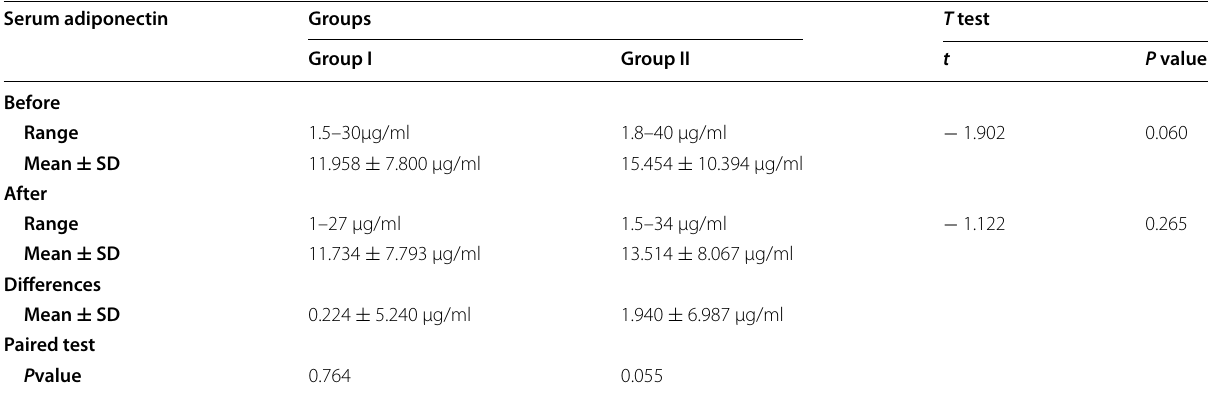
Table 11 Comparison between each group before and after treatment and the two studied groups according to serum adiponectin